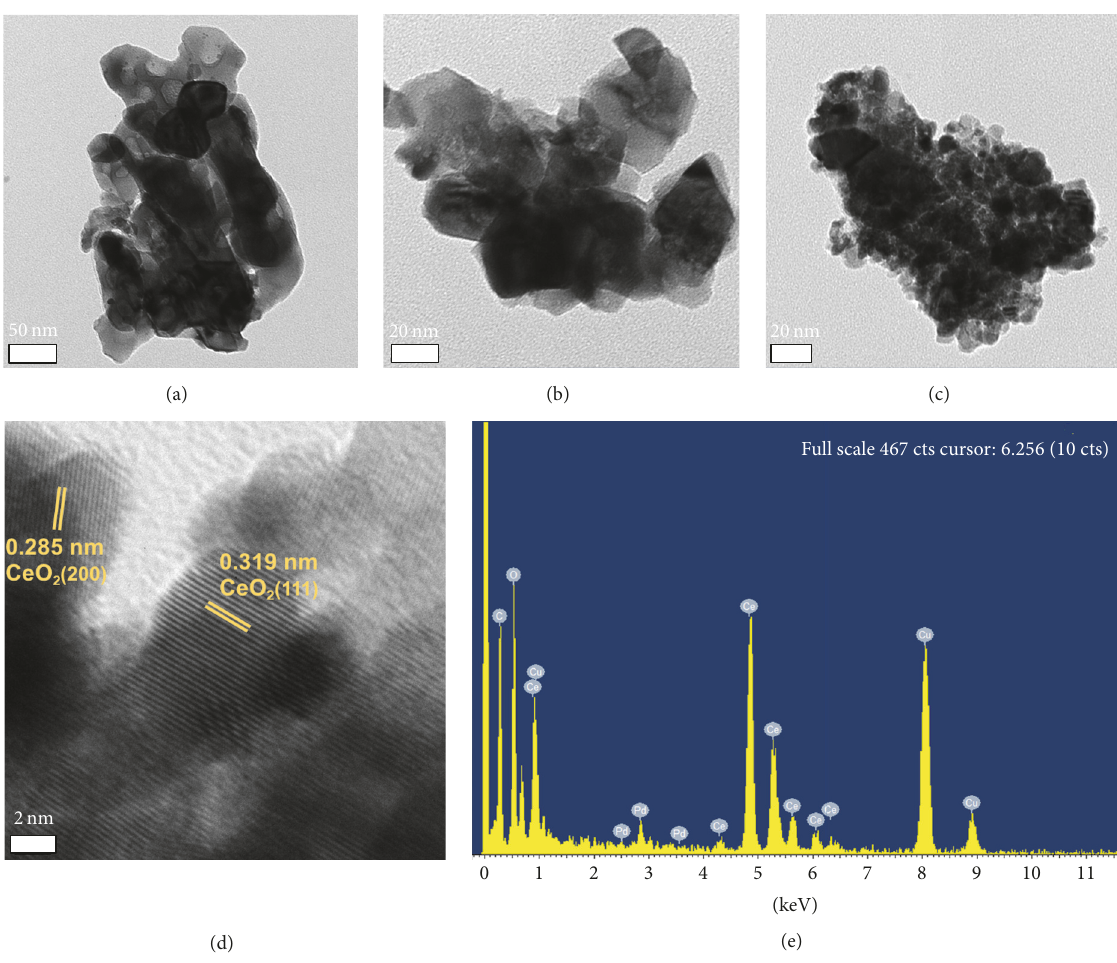
Figure 5: TEM images of the Pd-impregnated ceria catalysts. (a) 3Pd-CeO2-T-Cl, (b) 3Pd-CeO2-T-N, and (c) 3Pd-CeO2-B-N. (d) High- resolution TEM image of the 3Pd-CeO2-B-N catalyst indicating the crystallite planes of CeO 2 ; (e) the corresponding EDX spectrum of the 3Pd-CeO2-B-N catalyst based on TEM image in